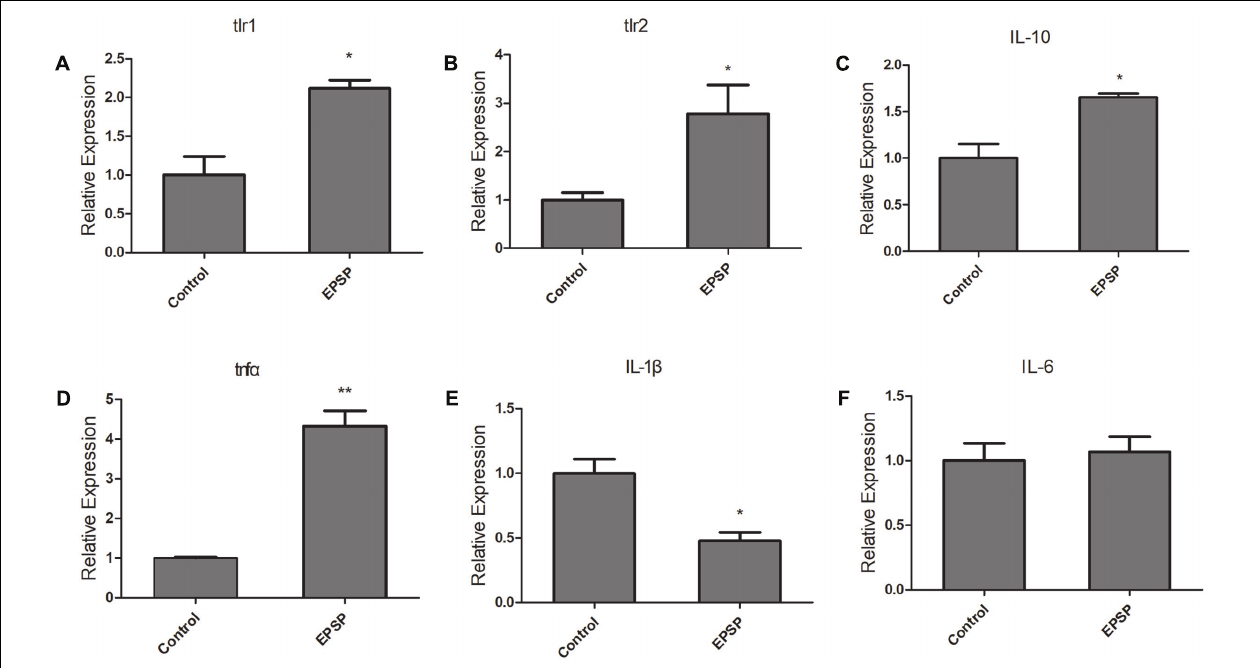
FIGURE 7 | Exopolysaccharide-protein complex (EPSP) modulated immune response in ZFL cells via TLR1 and TLR2. The mRNA levels of TLR1 (A) , TLR2 (B) , IL-10 (C) , TNF α (D) , IL-1 β (E) , and IL-6 (F) in ZFL cells from control and EPSP treatment (10 µ g/mL) groups after 24 h treatment. Asterisks indicate significant difference between the control and EPSP treatment group ( ∗ P < 0.05, ∗∗ P < 0.01, ∗∗∗ P <